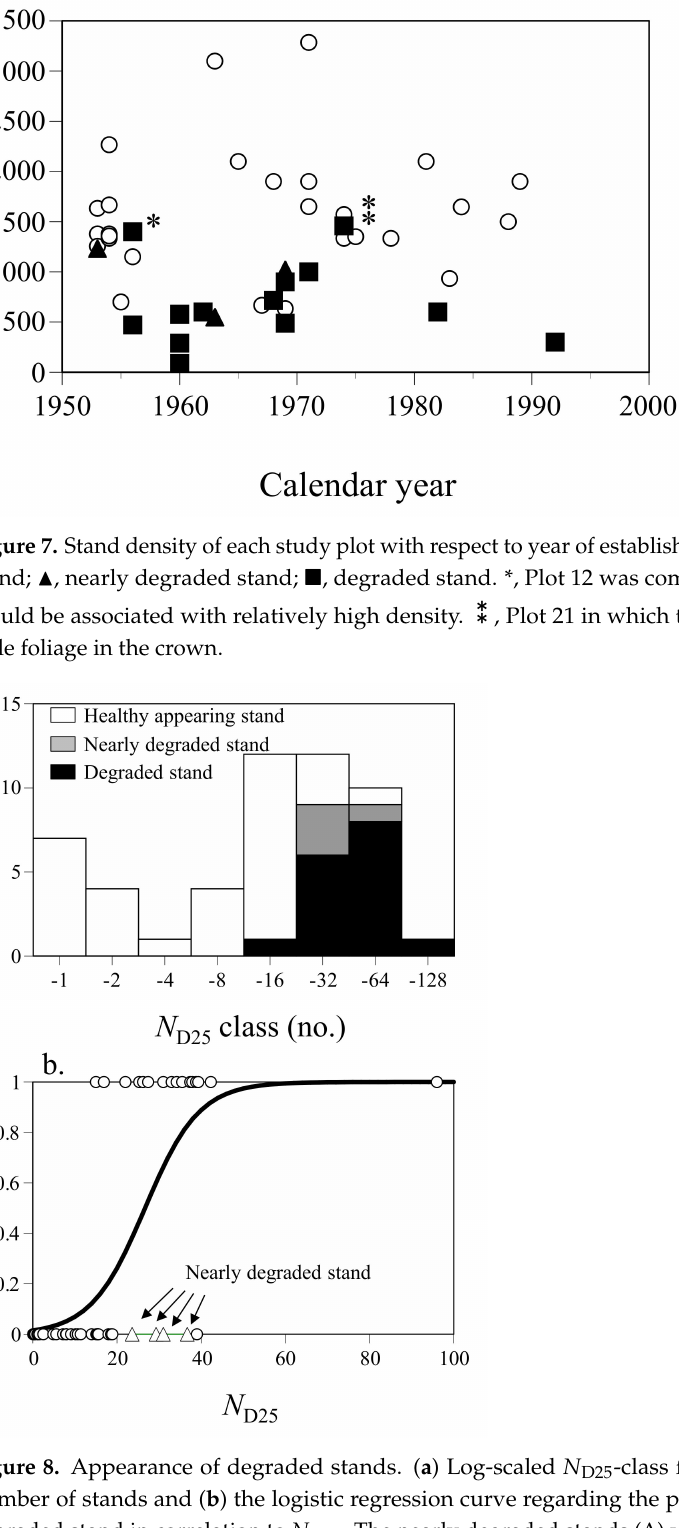
Figure 8. Appearance of degraded stands. ( a ) Log-scaled N D25 -class frequency histogram of the number of stands and ( b ) the logistic regression curve regarding the probability of appearance of degraded stand in correlation to N D25 . The nearly degraded stands ( ∆ ) were included as the healthy appearing stands in the